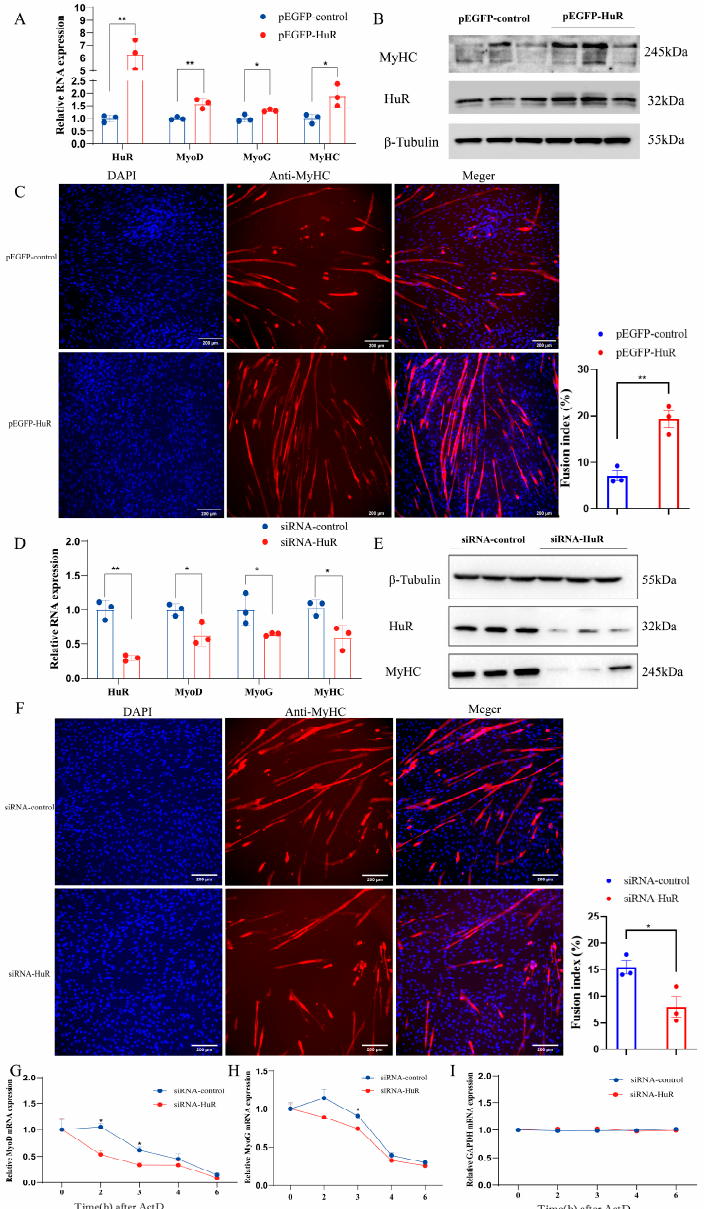
Figure 2. HuR promotes the differentiation of goat MuSCs. ( A ) The expression levels of HuR and muscle differentiation marker genes (MyoD, MyoG, and MyHC) were determined in MuSCs transfected with pEGFP-HuR or pEGFP-control. ( B ) MyHC protein levels were determined in MuSCs transfected with pEGFP-HuR or pEGFP-control. ( C ) Immunofluorescence detection of MyHC in MuSCs after 4 days of pEGFP-HuR transfection. DAPI labelling was used to view cell nuclei (blue). The fusion index of myotubes was calculated. Scale bars = 200 µ m. ( D ) The expression levels of HuR and muscle differentiation marker genes (MyoD, MyoG, and MyHC) were determined in MuSCs transfected with siRNA-HuR or siRNA-control. ( E ) The protein levels of MyHC were determined in MuSCs transfected with siRNA-HuR or siRNA-control. ( F ) Immunofluorescence examination of MyHC-stained cells transfected with siRNA-HuR or siRNA-control for four days. Cell nuclei were visualized with DAPI (blue). The fusion index of myotubes was calculated. Scale bars = 200 µ m. ( G , H ) HuR knockdown inhibits the stability of MyoD and MyoG mRNA. ( I ) HuR knockdown does not affect the stability of the internal reference gene GAPDH. The data are represented by the average of three independent experiments ± SEM; * p < 0.05; ** p <